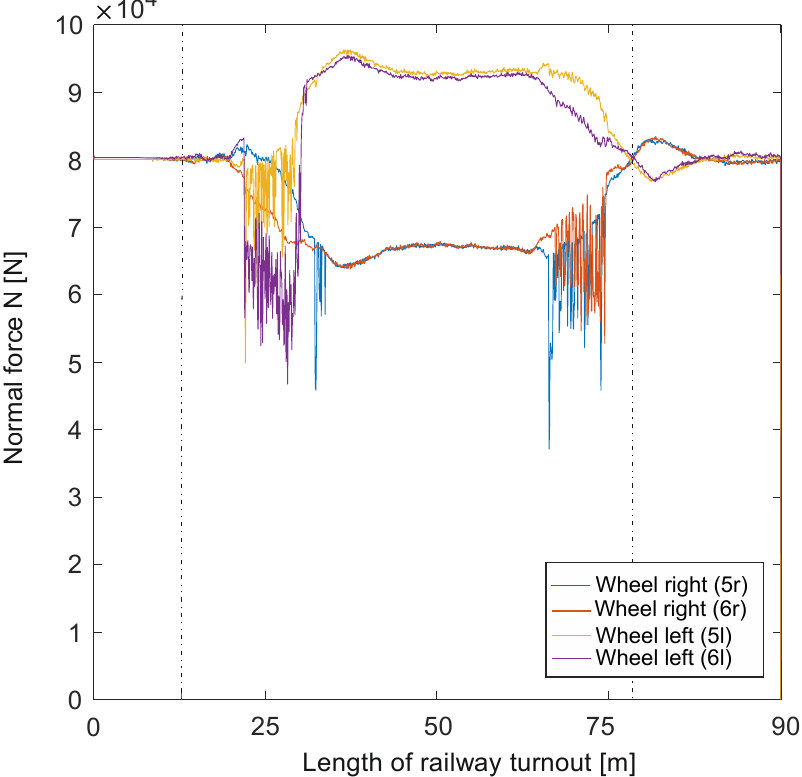
Figure 12. Normal force at 100 km/h on a straight track through a turnout.